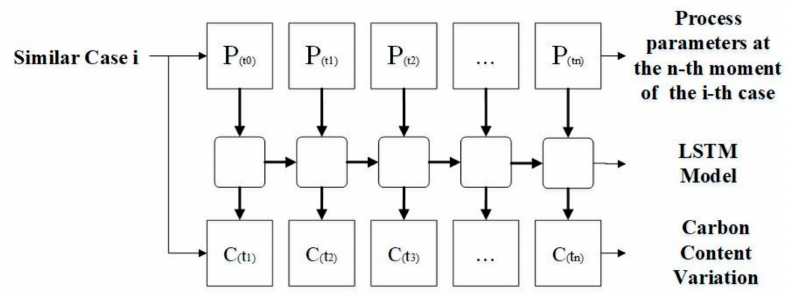
Figure 8. Process of model training.